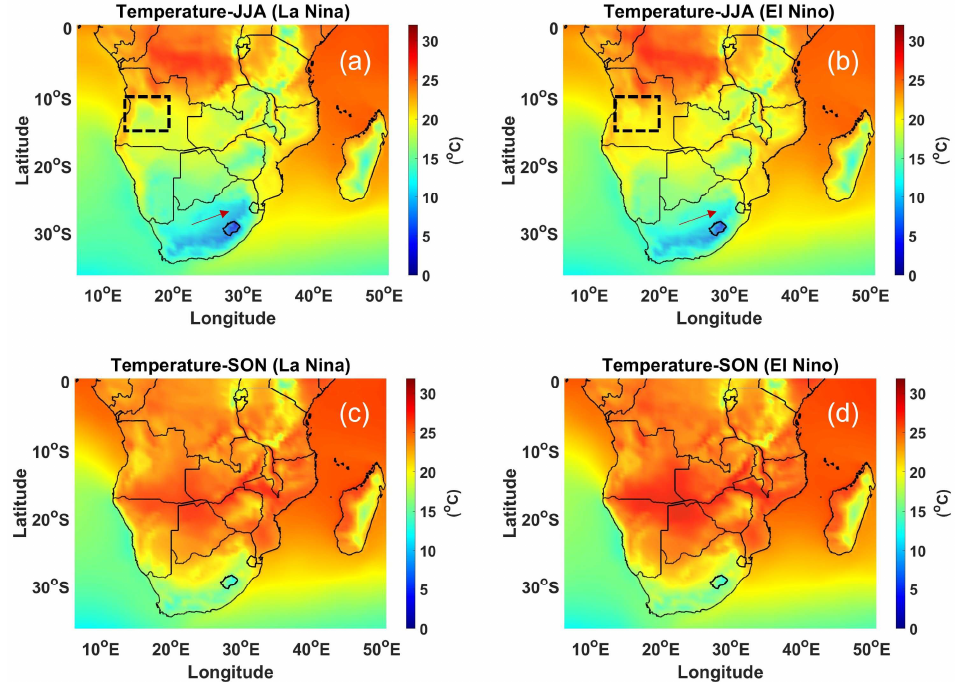
Figure 9. Spatial distribution of temperature for the JJA ( a , b ) and SON ( c , d ) periods during the La Niña ( a , c ) and El Niño ( b , d ) events.